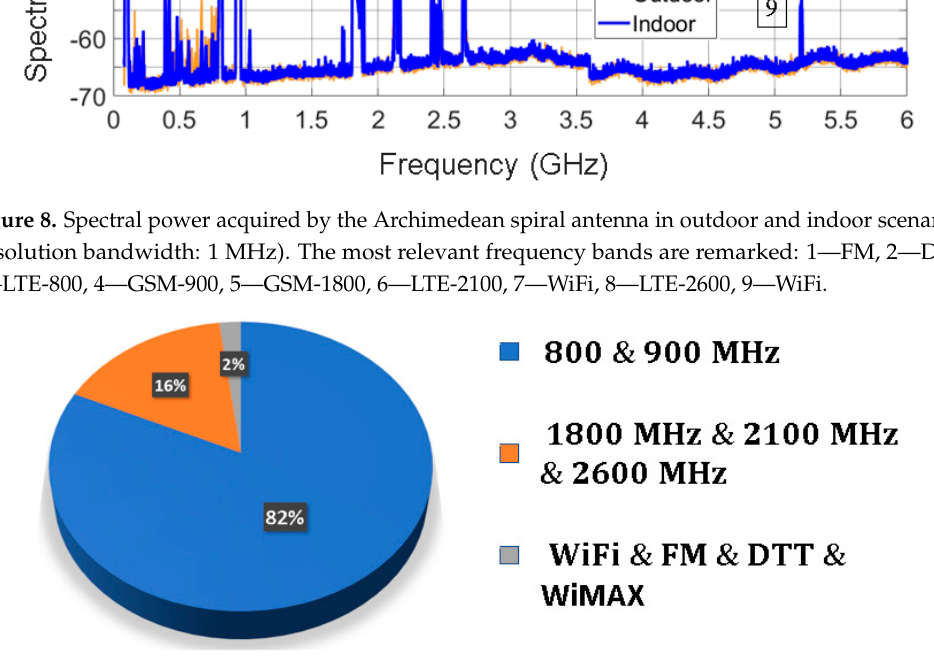
Figure 9. Distribution of the acquired spectral power outdoors.